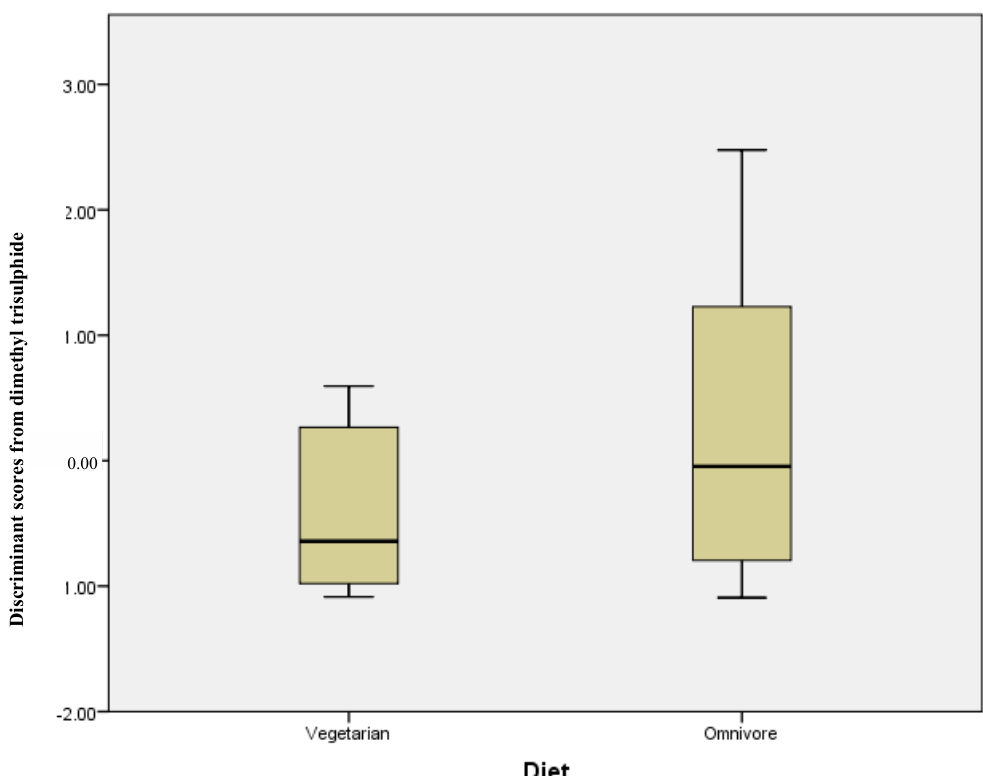
Figure 3. Discriminant scores’ box plots showing a lack of differentiation of stool samples from vegetarian and omnivore volunteers.